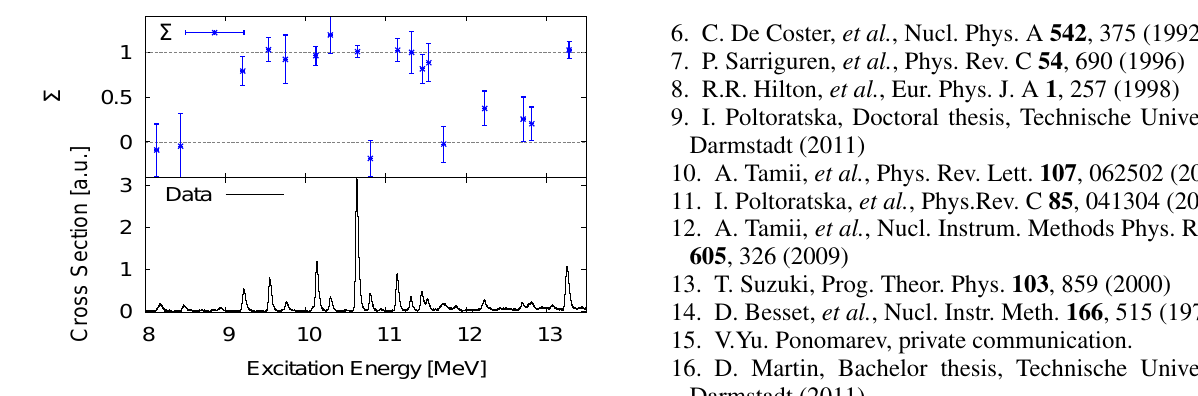
Fig. 4. (color online) Total spin transfer Σ (upper panel) and the corresponding peaks in the excitation energy spectrum (lower panel) for the reaction 26 Mg( p , p (cid:48) ) at a proton energy of 295 MeV at 0 ◦ .